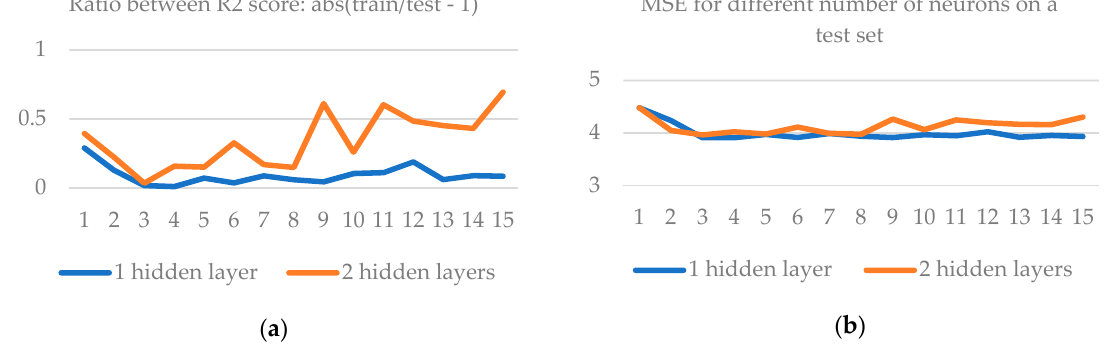
Figure A1. Statistics for di ff erent ANN models where several hyperparameters are changed (number of hidden layers and number of neurons per hidden layer). ( a ) R2 score training test ratio ( b ) MSE on a test set. All models have radon and 2 particulate matter related PCA components as inputs. Figure A1b uses log10